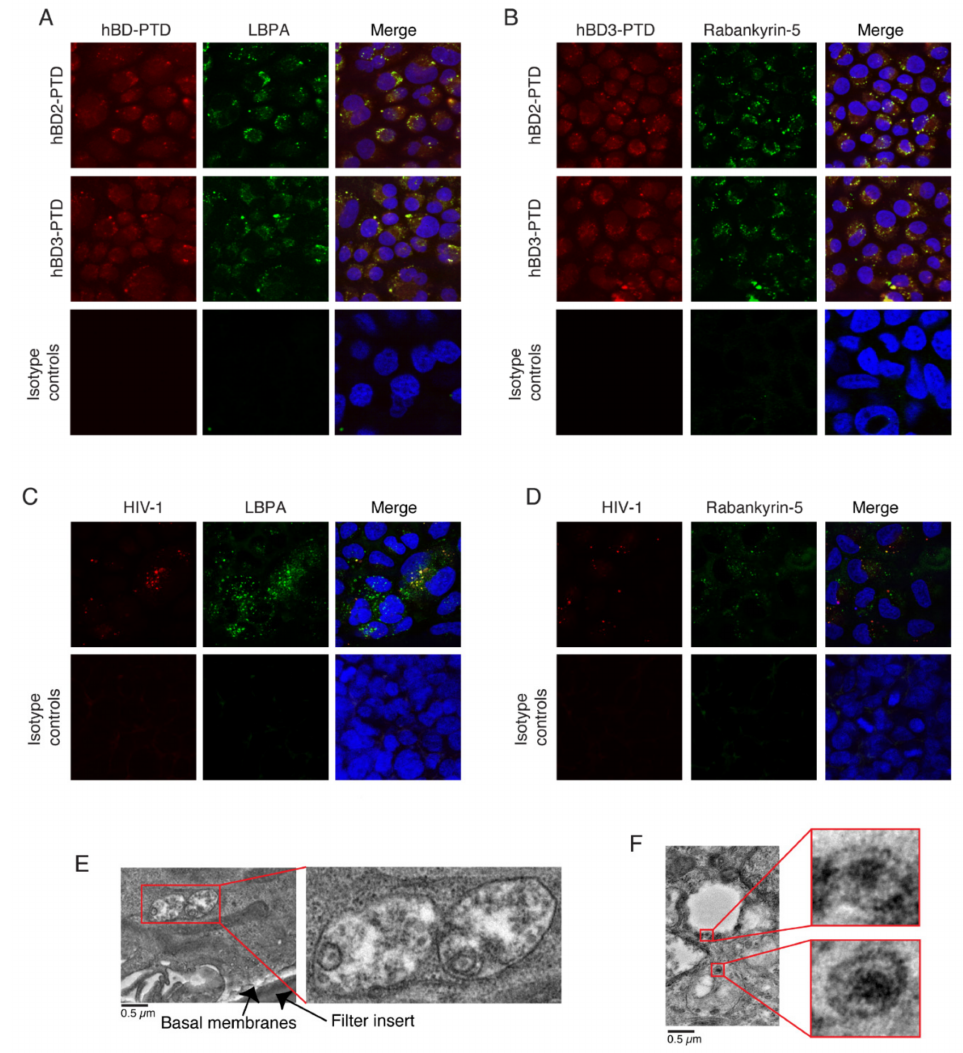
Figure 3. Colocalization of hBD-2 PTD and hBD-3 PTD with markers of MVB and vacuoles. Polarized tonsil epithelial cells were exposed to HIV-1 SF33 (20 ng/mL); after 48 h, hBD-2 PTD and hBD-3 PTD (50 µ g/mL each) were added to the apical surface of epithelial cells for 2 h. Cells were washed, fixed, and coimmunostained for hBD-2 PTD or hBD-3 PTD (both